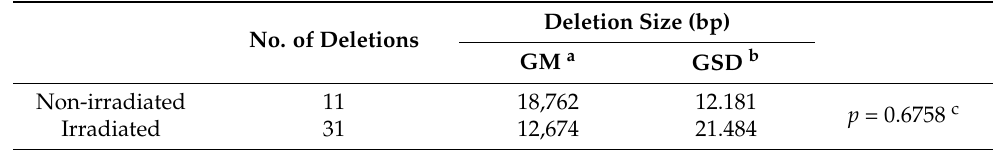
Table 5. Comparison of the sizes of the deletions found in the F1 mice of non-irradiated and irradiated